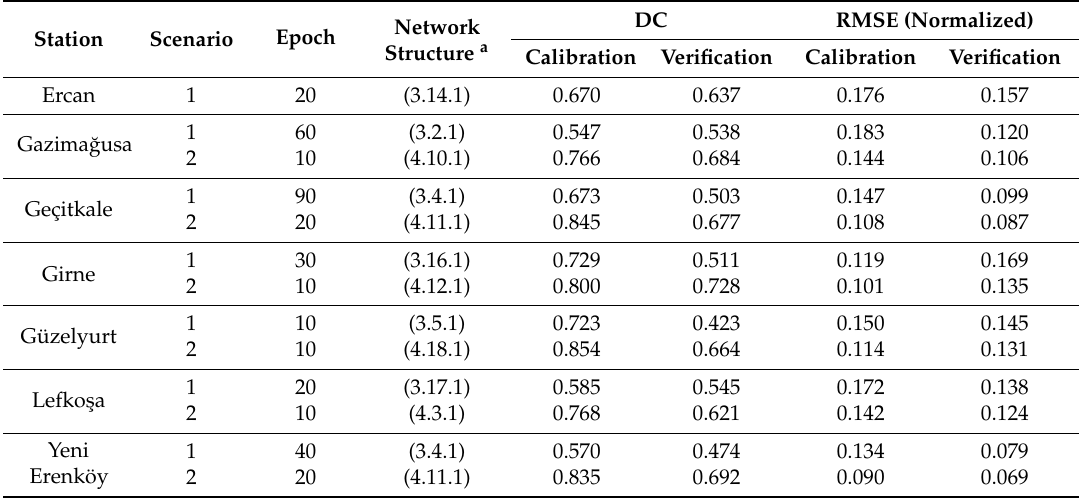
Table 4. Results of monthly precipitation predictions by FFNN for both scenarios 1 and 2.